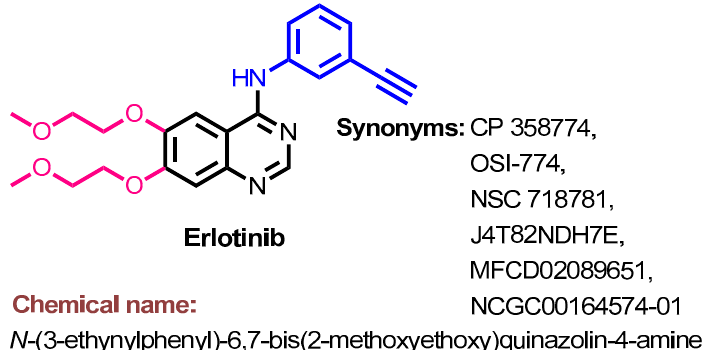
Figure 25. Chemical structure/name/synonyms of erlotinib.